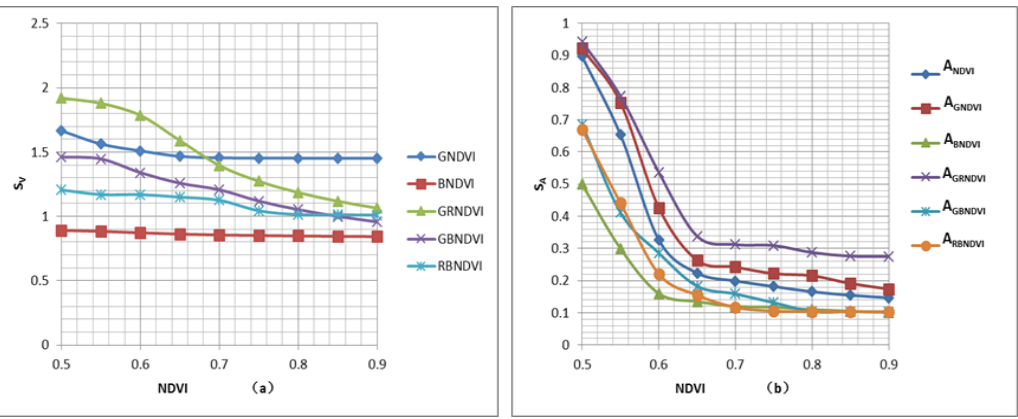
Figure 3. ( a ) Relative sensitivity and anti-interference curves of NDVI and VNDVI; ( b ) Relative sensitivity and anti-interference curves of NDVI and A VNDVI